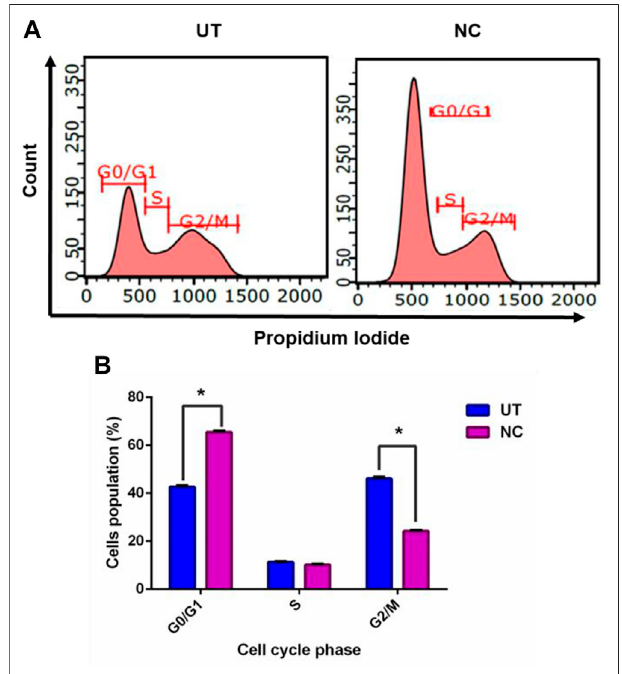
FIGURE 2 | Effect of NC leaves ’ 80% ethanol extract on the MCF-7 cell cycle. (A) Representation of DNA histogram of NC leaves ’ 80% ethanol extract – treatedcells,withUTascontrolat72 hofincubation.DNAhistograms display cell cycle phases of treated cells, namely, G1/G0, S, and G2/M ( n (cid:2) 3). (B) The proportion of cells according to the cell cycle phase are presented in percentage mean ± SD ( n (cid:2) 3). * indicates p < 0.05 concerning untreated.